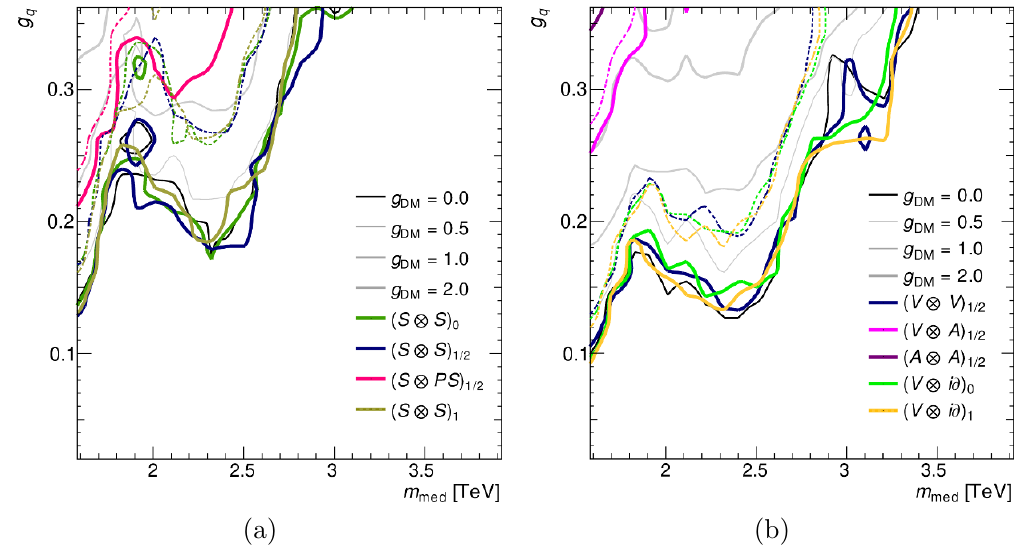
Figure 1 . 95% C.L. (3 (cid:27) ) exclusion limits on g q from the null result of present searches for narrow resonances in dijet (cid:12)nal states at the LHC obtained by setting m DM = 50 GeV and g DM to the value required by the detection of 150 signal events at XENONnT indicated by solid (dotted) coloured lines. Exclusion limits are presented for simpli(cid:12)ed models with a scalar mediator (a) and for models with a vector mediator (b). We show only the models that are not yet fully excluded by dijet searches in the relevant parameter range. In both panels we used data from a CMS search for narrow resonances in (cid:12)nal states involving a dijet corresponding to an integrated luminosity of 36 fb (cid:0) 1 . For models ( S (cid:10) S ) (a) and ( V (cid:10) V ) (b), the (cid:12)gure also shows 95% C.L. exclusion 1 = 2 1 = 2 limits obtained by setting g DM to XENONnT-independent values (grey